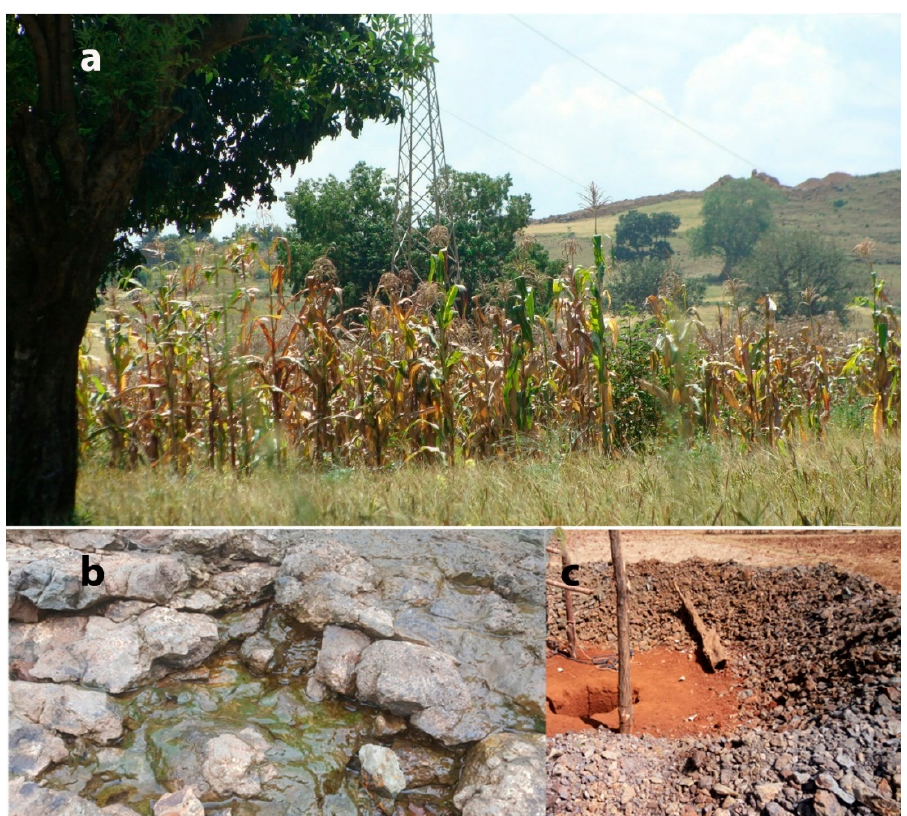
Figure 2. The Robit Bata watershed: ( a ) landscape view; ( b ) fractured quaternary basalt bedrock; ( c ) excavated soil from a well. The stones in the foreground are from the regolith layer.